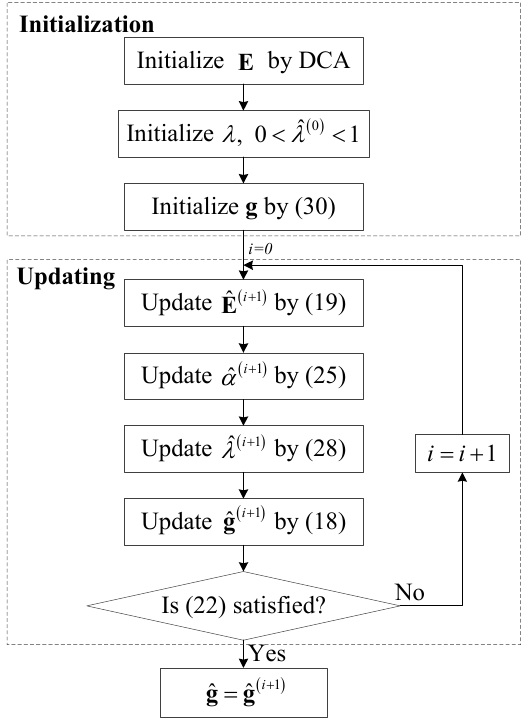
Figure 2. Flow chart of the logarithmic Laplacian prior based Bayesian inverse synthetic aperture radar (ISAR) imaging